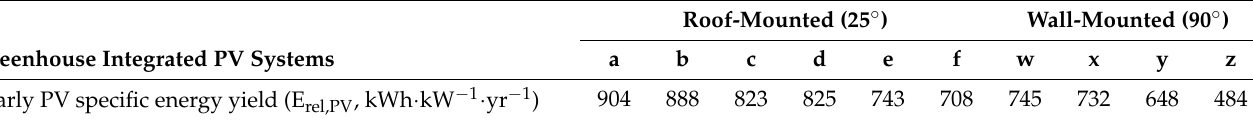
Table 5. Yearly specific energy yields for the different greenhouse integrated PV systems in Borlänge, Sweden. Roof-Mounted (25 ◦